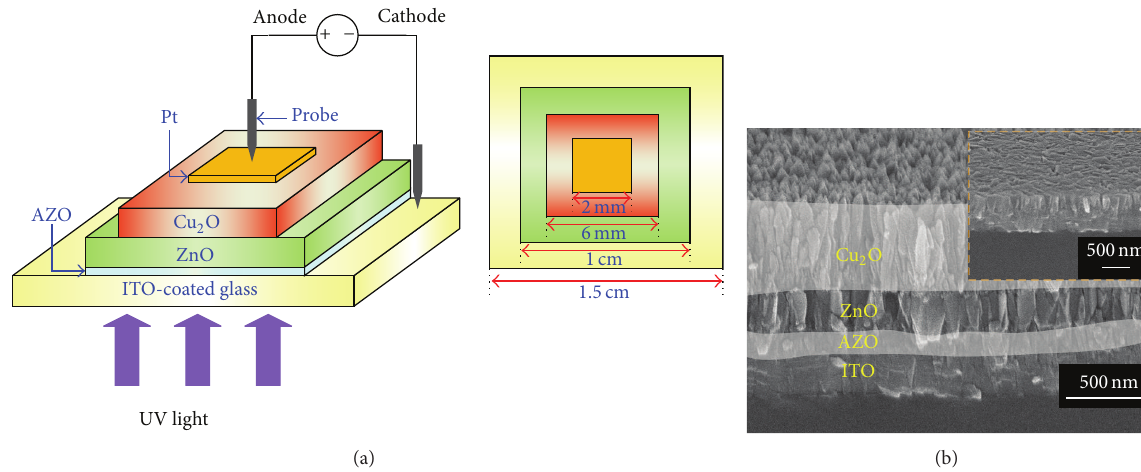
Figure 1: Schematic device structure and SEM images of prepared UV-PDs. (a) Schematic device structure and (b) tilted-view images of ZnO (HTG)/AZO/ITO and p-Cu 2 O/ZnO (HTG)/AZO/ITO